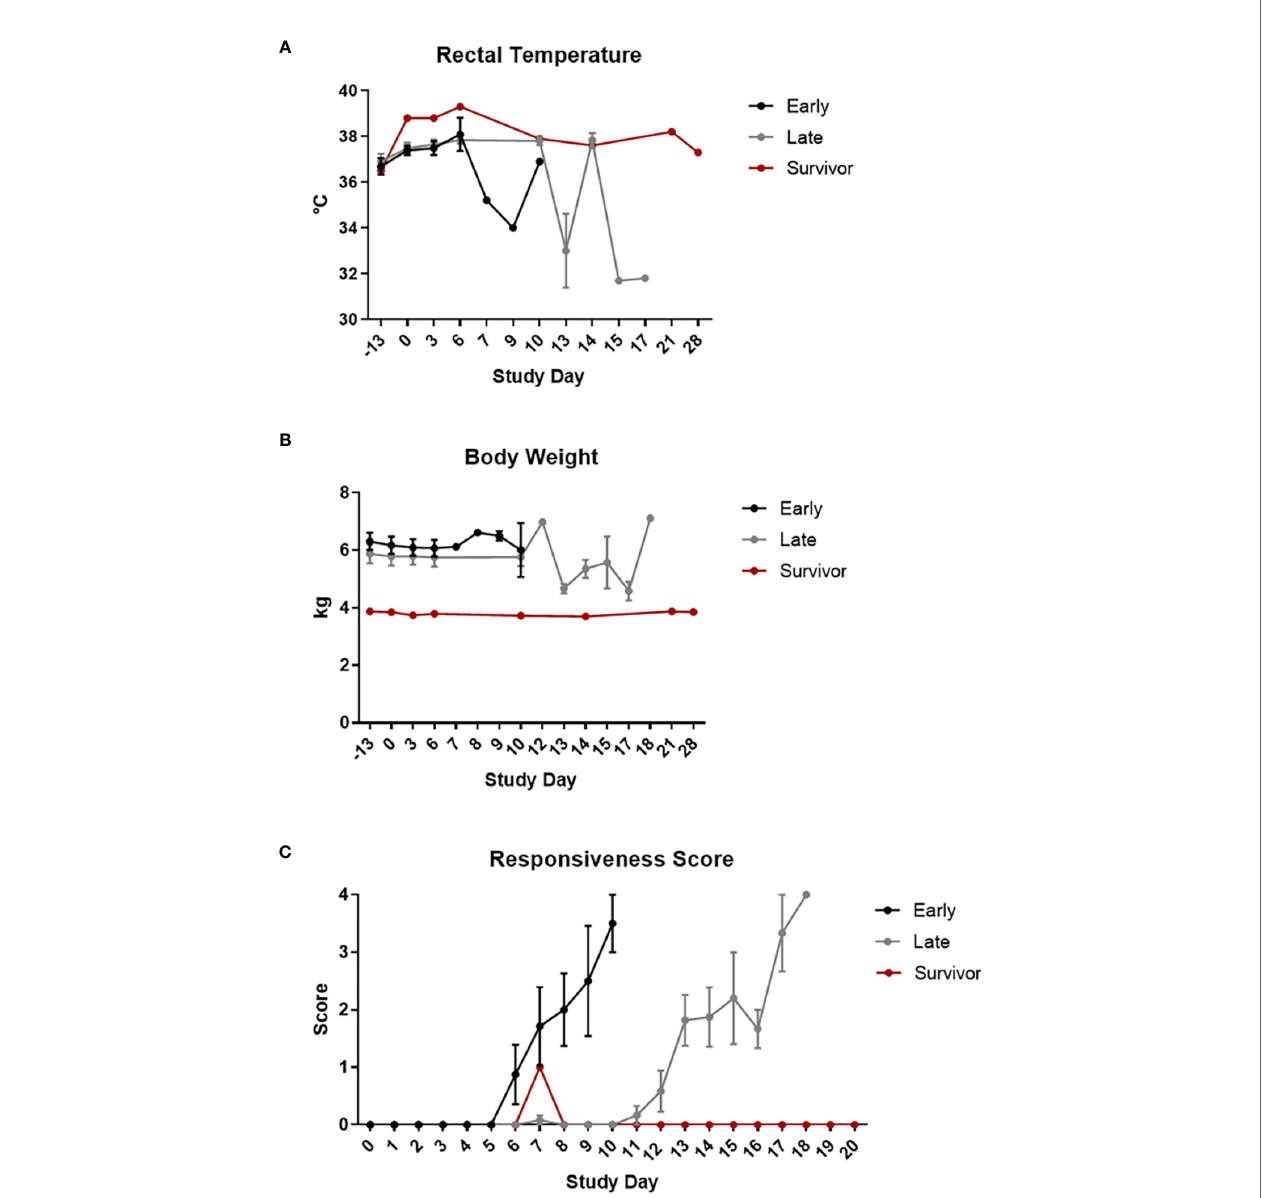
FIGURE 2 | Clinical Disease. Rectal temperatures (A) , body weights (B) , and responsiveness scores (C) are shown grouped by survival phase (i.e., early-phase, late-phase, and survivor). Error bars represent the standard error measurement